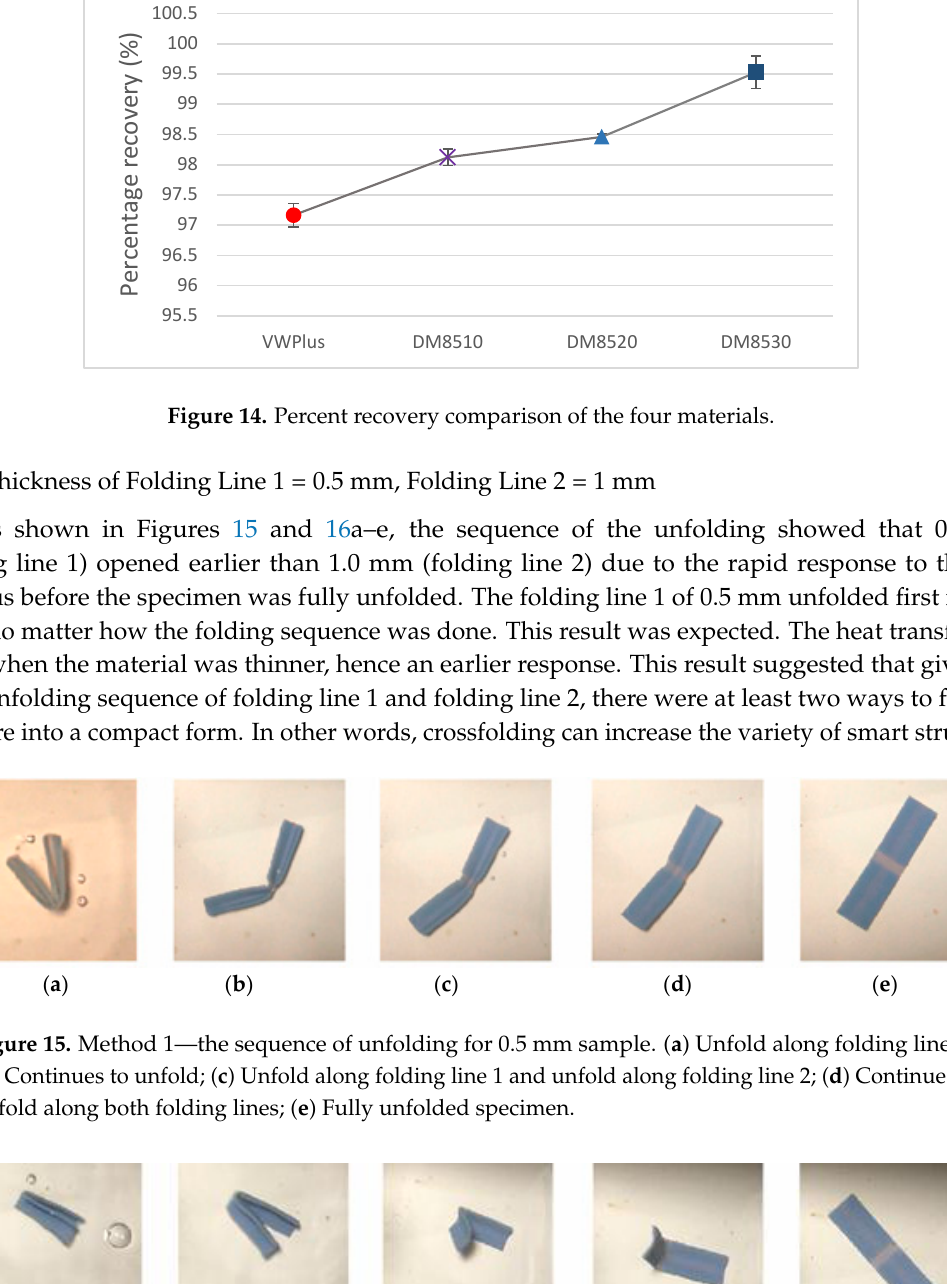
Figure 14. Percent recovery comparison of the four materials.